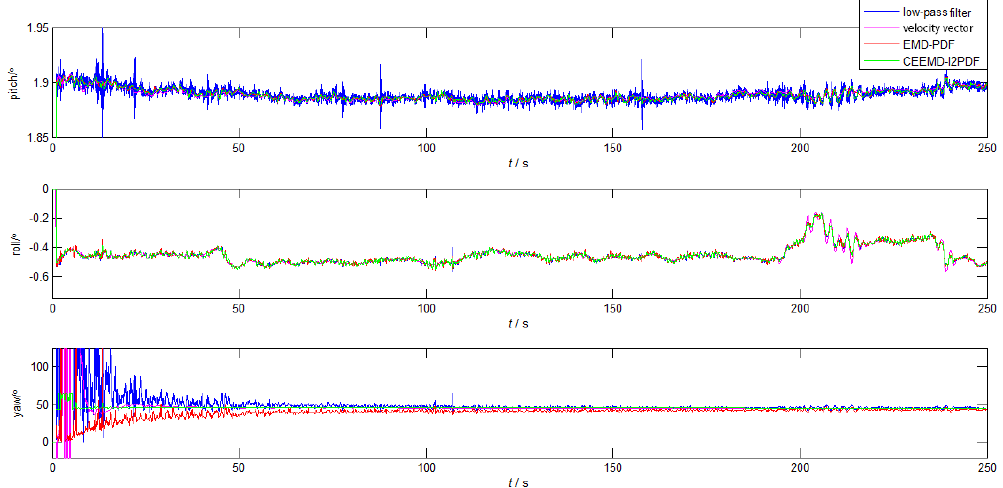
Figure 15. The alignment results in the ship mooring